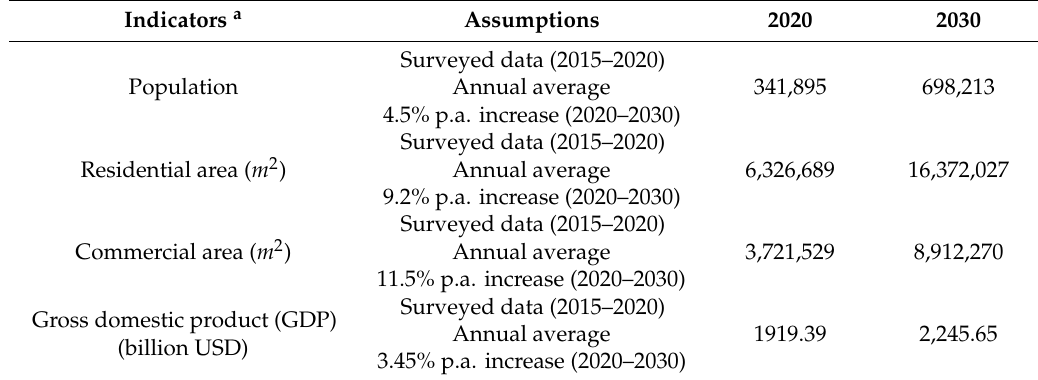
Table 1. The Quantitative Assumptions and Estimates of Economic Indicators for 2020–2030.